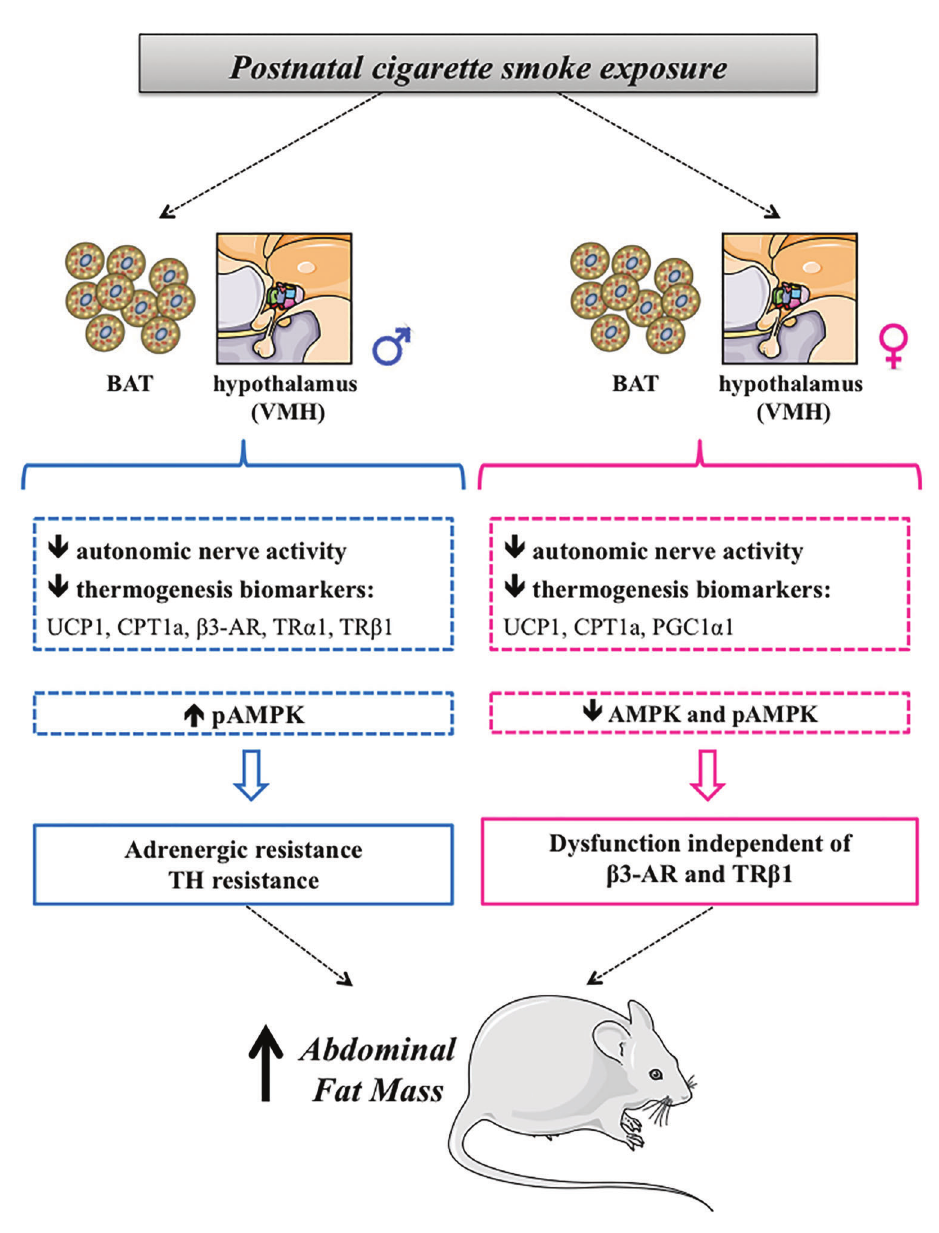
Figure 8. Smoking in critical windows of development causes epigenetic alterations and is a risk factor for adulthood obesity. BAT: brown adipose tissue; UCP1: uncoupling protein 1; b 3-AR: beta 3-adrenergic receptor; TR a 1 and TR b 1: thyroid hormones receptors a 1 and b 1; CPT1a: carnitine palmitoyltransferase 1a; PGC1 a : peroxisome proliferator-activated receptor-coactivator; VMH: ventromedial nucleus of the hypothalamus; AMPK: AMP-activated protein kinase; pAMPK: phosphorylated AMPK; TH: thyroid